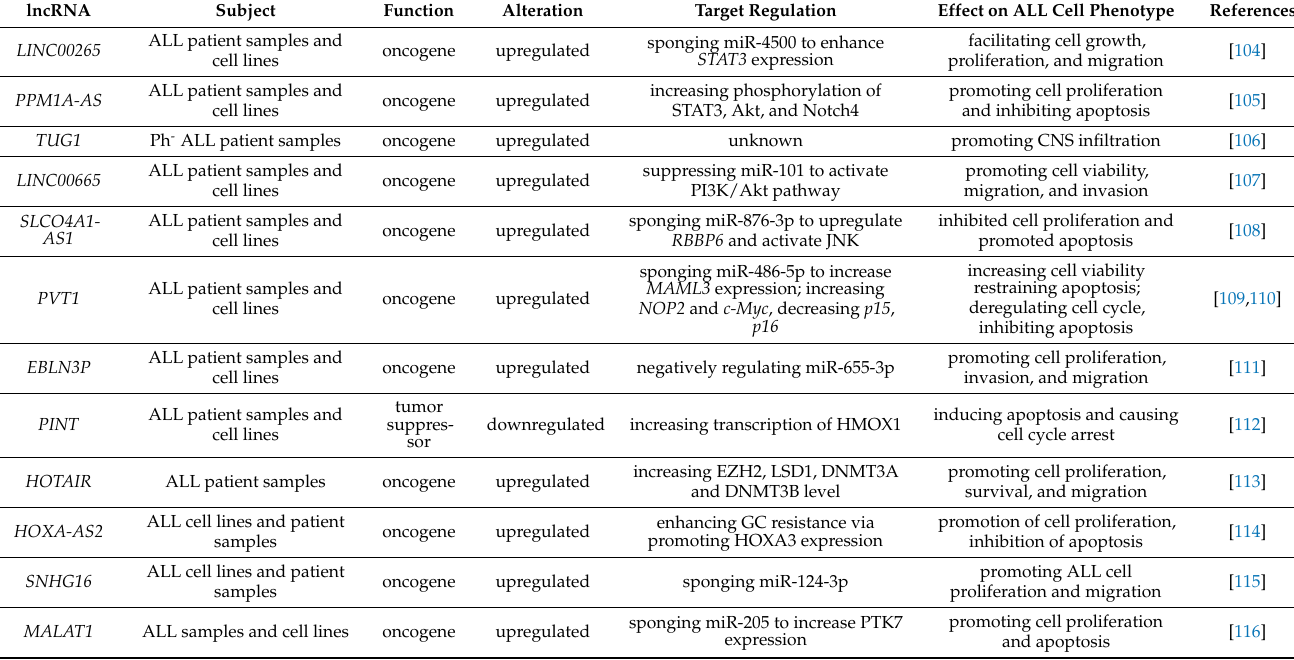
Table 3. List of lncRNAs implicated in ALL (B- or T-subtype not differentiated) pathogenesis and